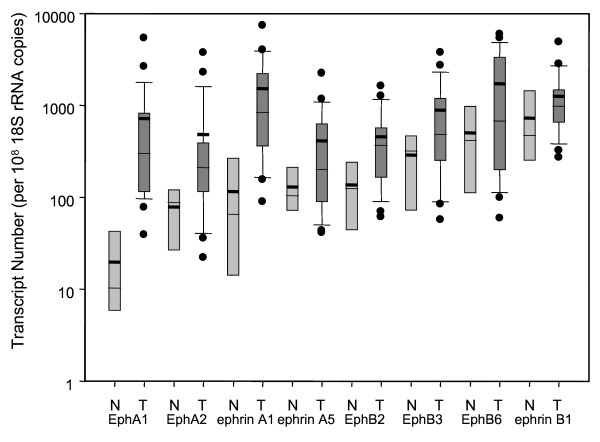
Transcript number of Eph and ephrin genes in non-malignant (N) and tumorigenic (T) tissues, relative to 108 copies of 18S rRNA shown on a log scale. Whiskers show the 10th–90th percentile range while the shaded areas show the 25th–75th percentile range. The thin and heavy horizontal lines represent the median and the mean respectively.